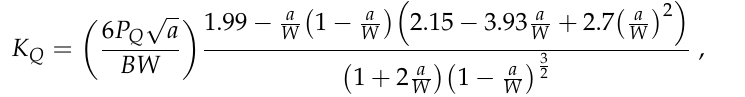
Figure 13. Fracture surfaces of ( a ) Br-PLA, ( b ) Cu-PLA, ( c ) SS-PLA, ( d ) MI-PLA, and ( e ) pure PLA, printed with a 0.3 mm print layer height. Br-PLA is shown at higher magnification in ( f ). ( g ) Corresponding fracture toughness values for mate- rials (printed at a 0.3 mm layer height). In all mechanical tests, SS-PLA and MI-PLA performed nearly as well as pure PLA. These three material compositions show similar tensile responses, but the presence of me- tallic particles causes a lower ultimate strength and earlier onset of plastic deformation. In contrast, there is a significant and noticeable change in mechanical behavior in Br-PLA and Cu-PLA. These two material compositions have much lower ultimate strength and fracture toughness values. Large additions of metal particles in the Br- and Cu-PLA may